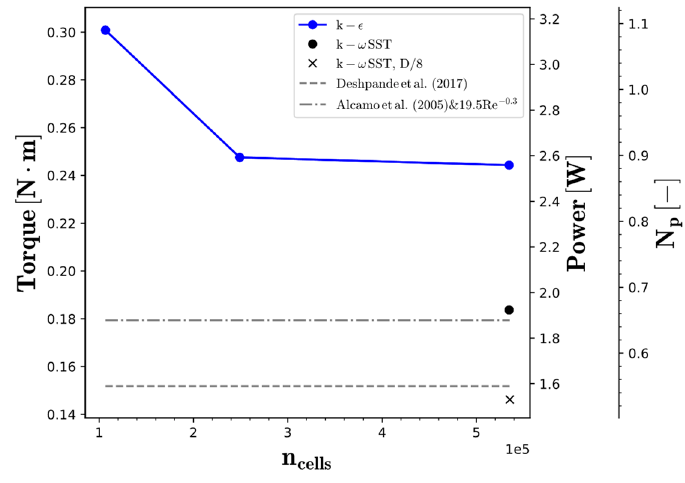
Figure 4. Mesh refinement effect for the unbaffled stirring tank with a Rushton turbine. Table 4. QOI for power number and vortex depth. Settings are 𝐷 = 𝑍 (cid:3046) (liquid height) = 0.2286 m, 𝑁 = 1.667 s − 1 , 𝑅𝑒 (cid:3005) = 87,000, 𝐹𝑟 (cid:3005) = 0.065.